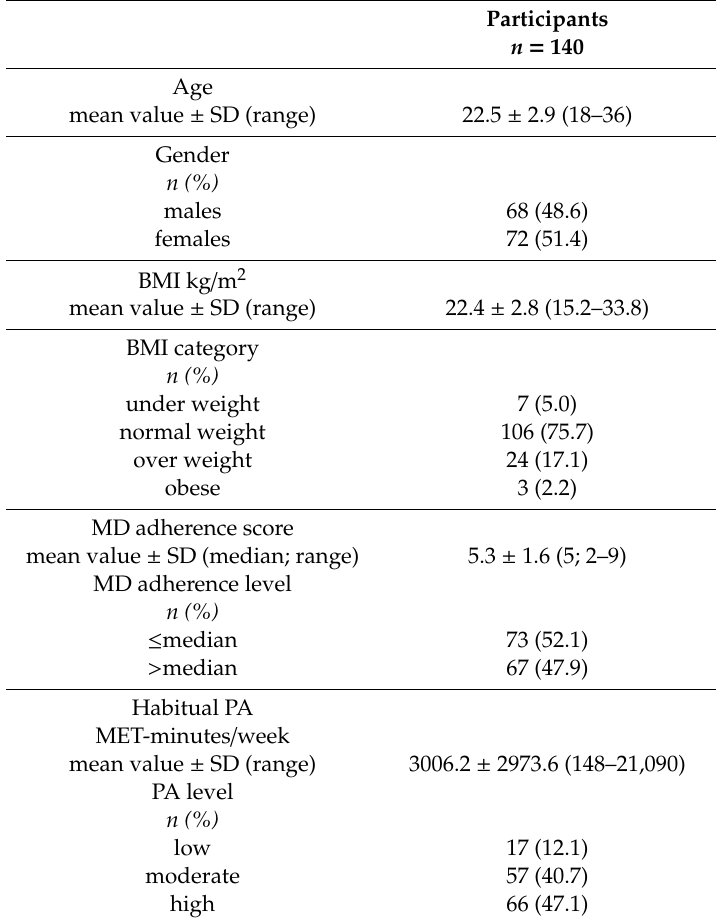
Table 1. Main characteristics of the total samples.